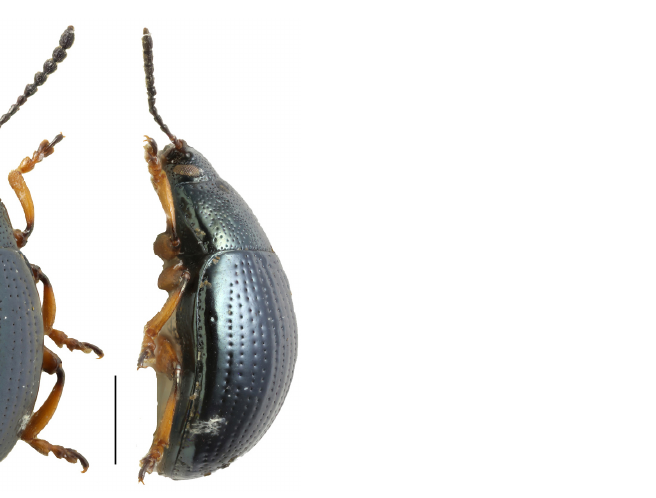
Figure 6. Sternoplatys fulvipes fulvipes Motschulsky, 1860, female (Russia, Primorye Province, env. of Kamenushka)—habitus in dorsal and lateral view. Scale bar—1 mm.